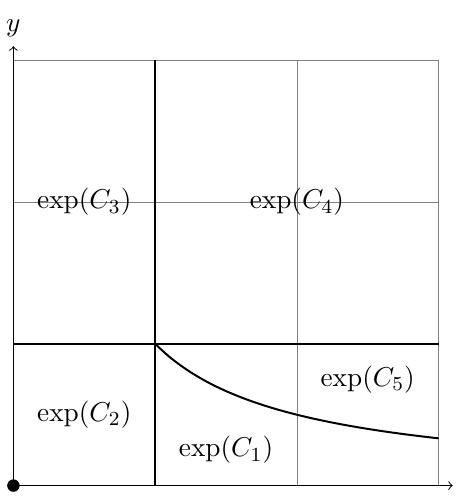
Figure 2 . The regions exp( C v ) for the normal fan of figure 1. The curve separating exp( C 1 ) from exp( C 5 ) is xy = 1